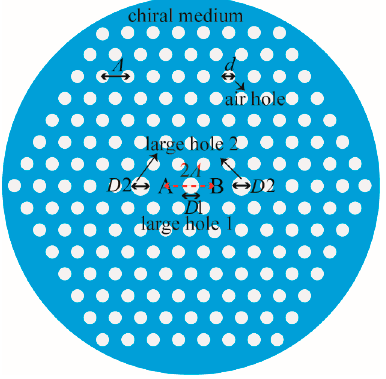
Figure 1. The schematic diagram of a chiral DC-PCF.